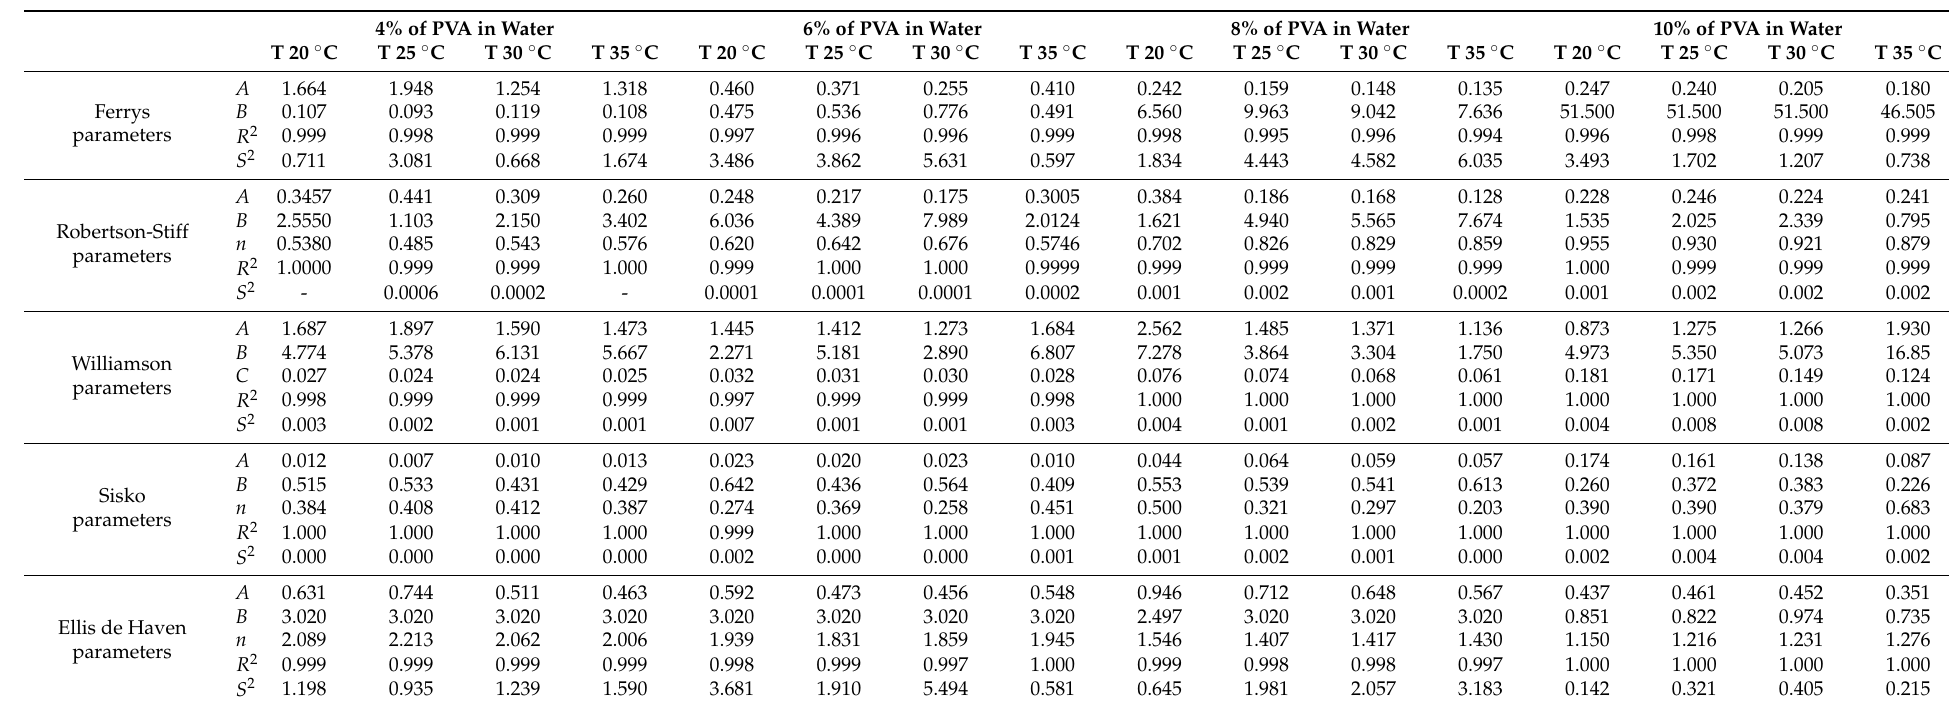
Table 3. Ferrys, Robertson-Stiff, Williamson, Sisko, and Ellis de Haven